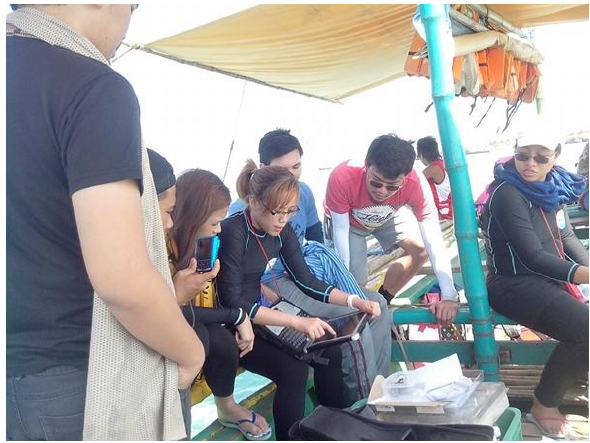
Figure 6. Training on spectral measurement and other field techniques in Bolinao,